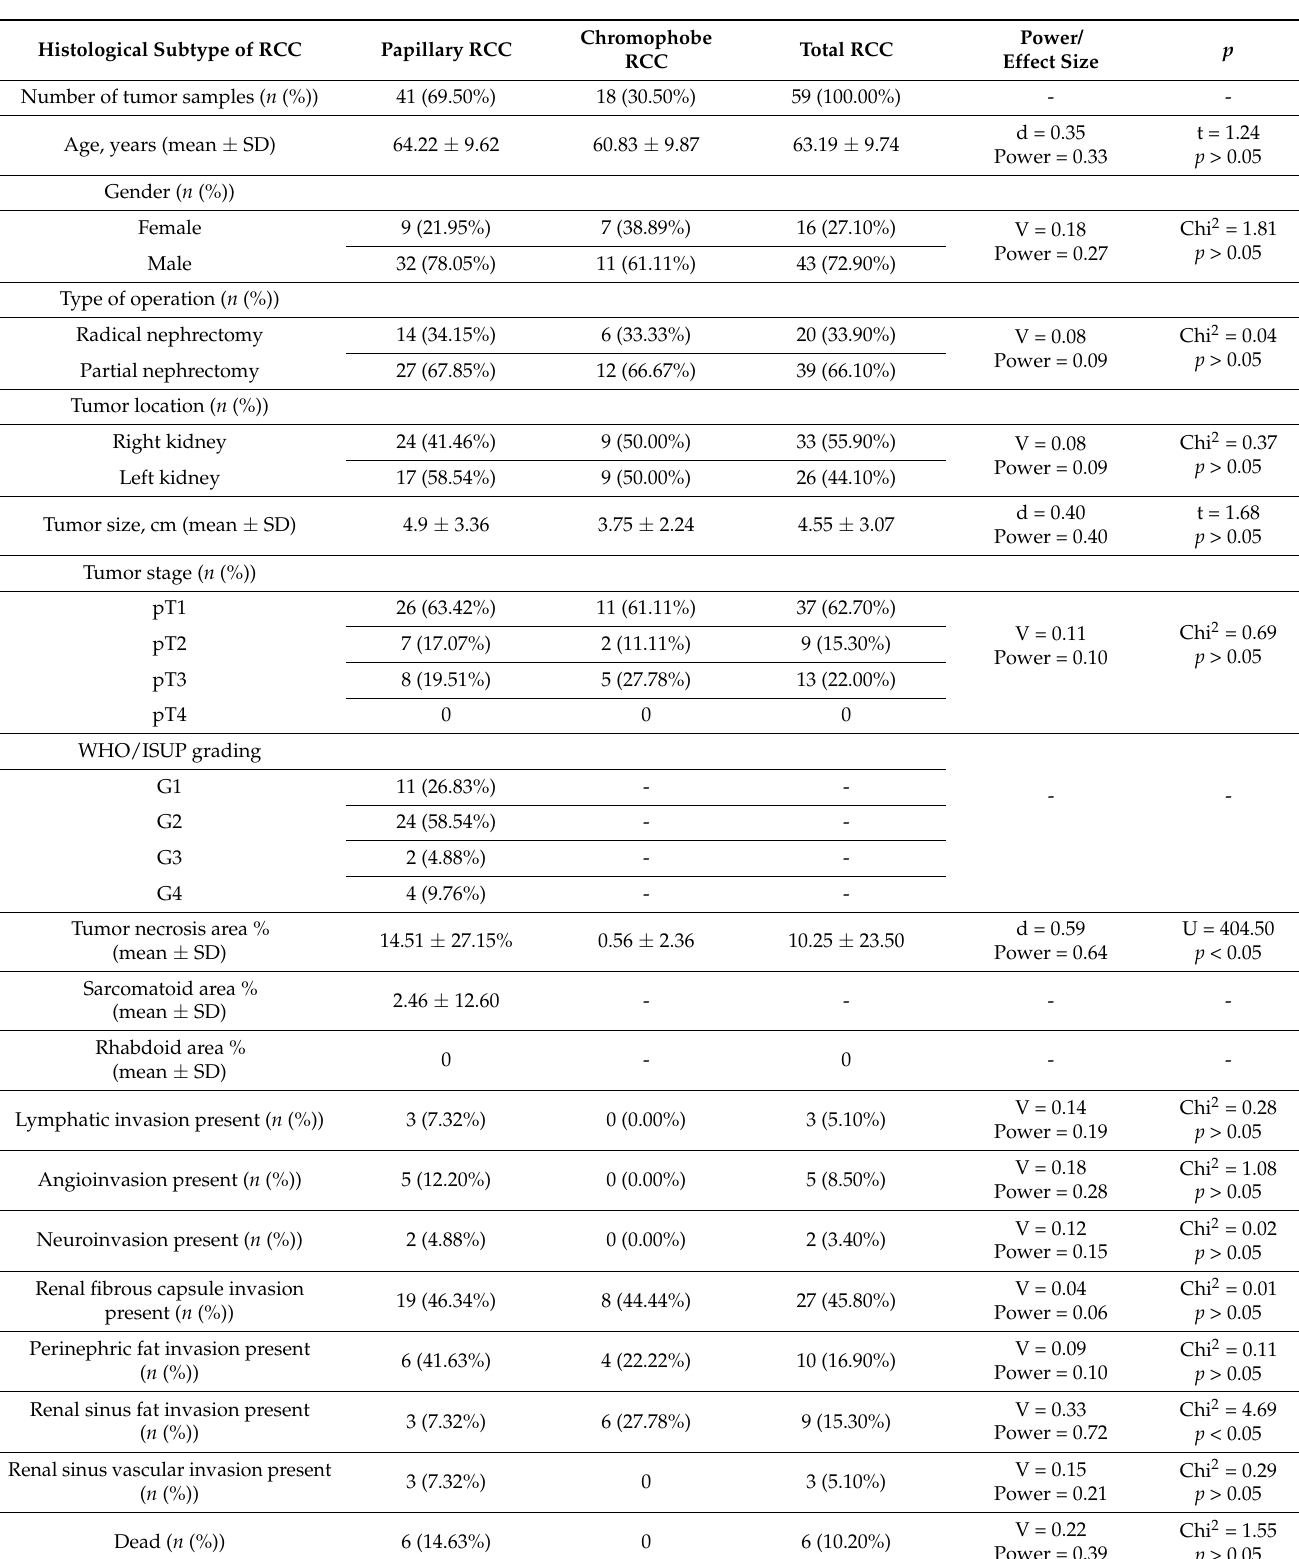
Table 2. Patients and tumor pathological characteristic of subtypes of non-clear cell renal cell